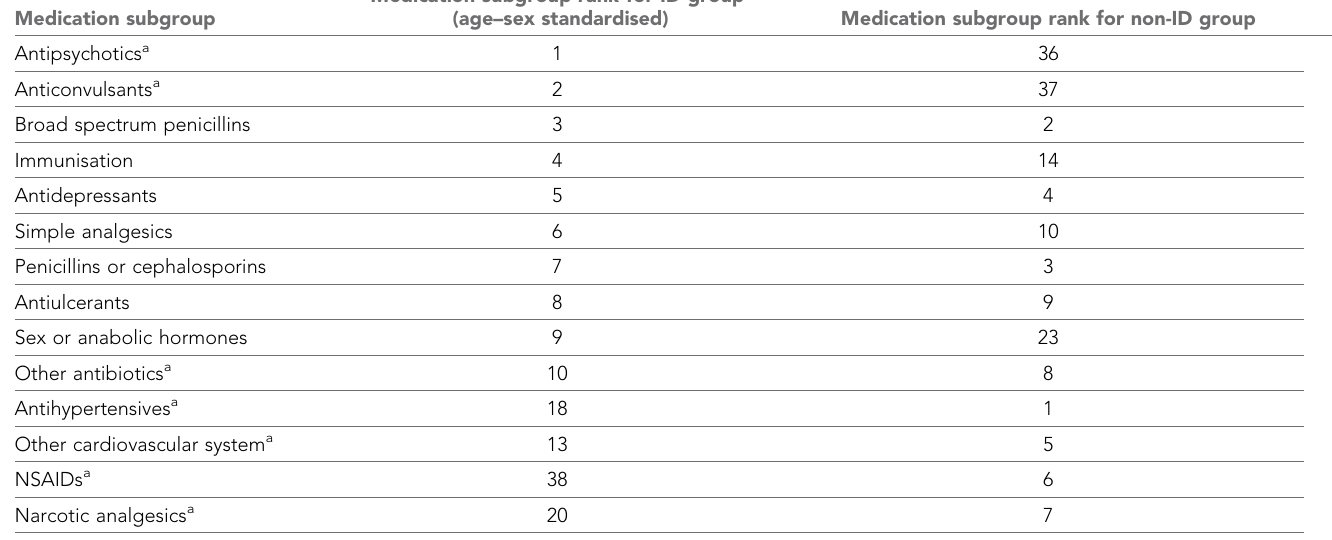
Table 2. Comparison of most frequently prescribed CAPS medication subgroups, non-ID group versus ID group. Top 10 CAPS medication subgroups ranked by frequency